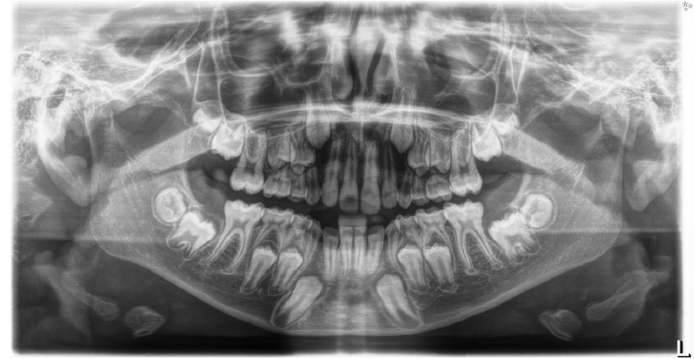
Figure 4. Study models before orthodontic therapy.